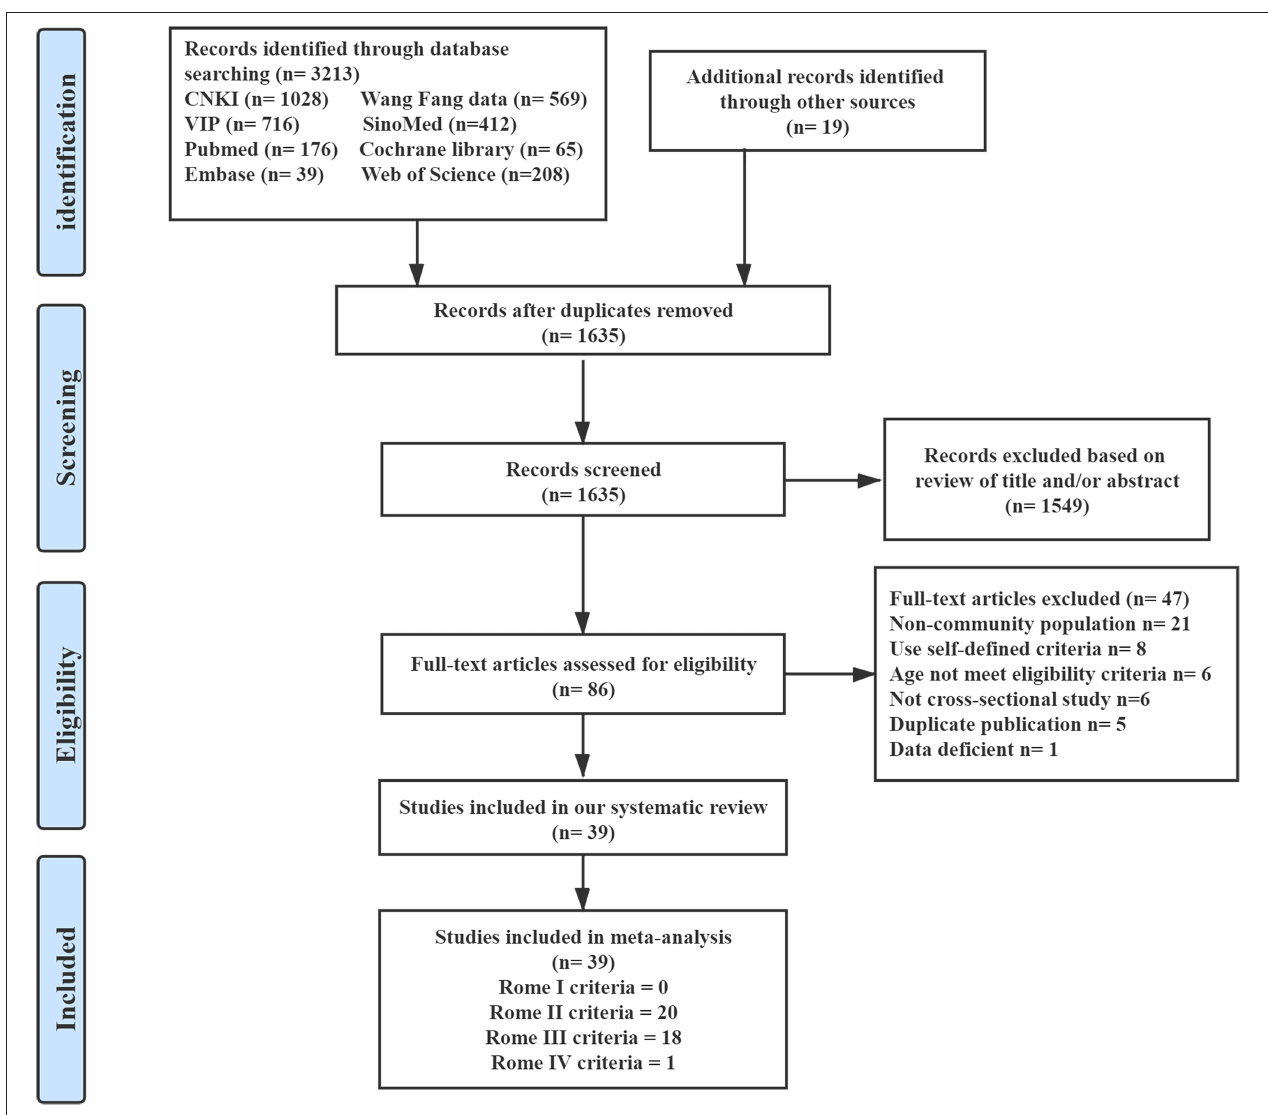
FIGURE 1 | Summary of evidence survey and selection. CNKI, the China National Knowledge Infrastructure; SinoMed, the Chinese Biomedical Literature Service System.